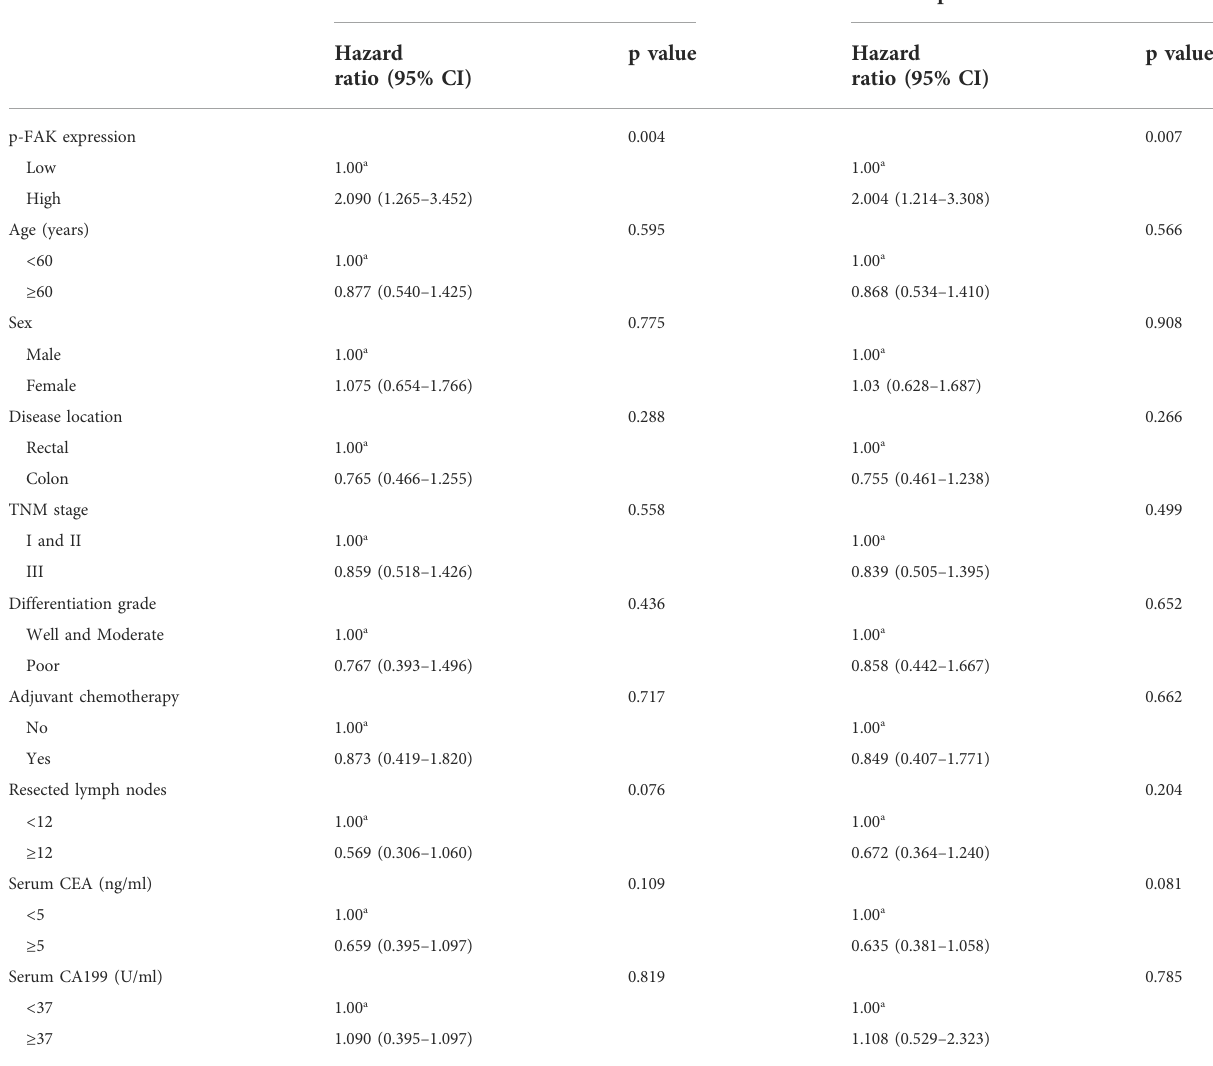
TABLE 2 Multivariable analysis of prognostic factors in overall survival and disease-speci fi c